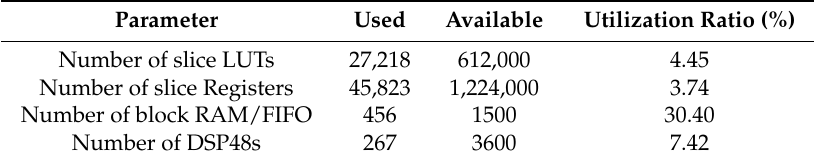
Table 8. The logic unit utilization ratio of the bilinear interpolation